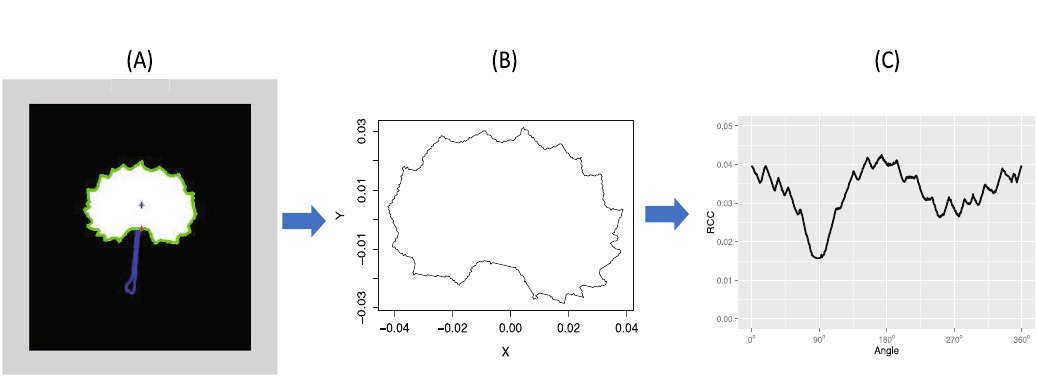
Figure 4. The shape curve generation process: recognize a shape outline demonstrated from ( A,B ); and transform a shape to a curve demonstrated from ( B,C